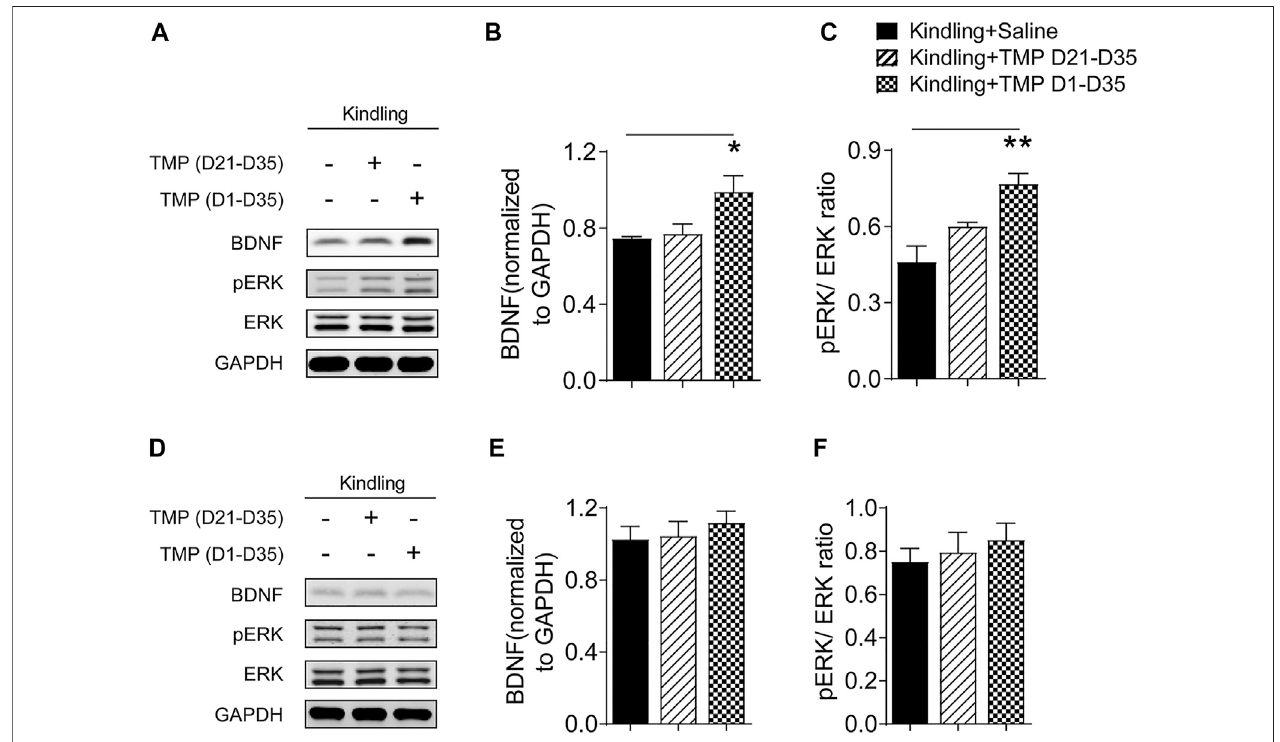
FIGURE 4 | Time dependent effects of TMP on hippocampal BDNF/ERK expression in late corneal kindling. (A – C) Levels of hippocampal BDNF (B) and pERK/ ERKratio (C) withTMP(50 mg/kg,i.p.D21-D35vs.D1-D35vs.saline)administrationinlatecornealkindling. (D – F) LevelsofBDNF (E) andpERK/ERKratio (F) inmPFC with TMP (50 mg/kg, i.p. D21-D35 vs. D1-D35 vs. saline) administration. Statistical analysis was performed by one way ANOVA, followed by Dunnett ’ s multiple comparisons (* p < 0.05, ** p < 0.01, vs. Kindling + Saline).